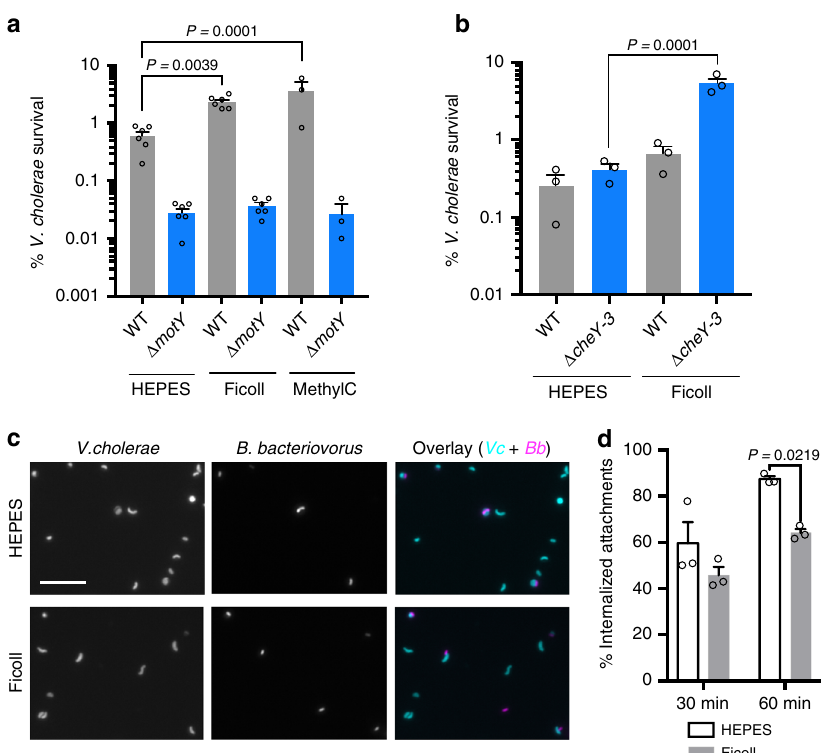
Fig. 4 Increasing viscosity reduces killing and invasion of motile V. cholerae . a , b The survival percentage of motile and non-motile V. cholerae strains in HEPES medium alone or supplemented with fi coll or methylcellulose to increase viscosity. Infections were carried out for 14 h with an MOI of 0.1. Survival percentage and SEM is shown for three to six biological replicates. c Fluorescence microscopy of B. bacteriovorus (magenta) and V. cholerae (cyan), following 1 h of infection at MOI 0.1 in HEPES or Ficoll-supplemented medium. Scale bar indicates 10 µ m. d Images from c were scored for externally attached or internalized B. bacteriovorus at 30 and 60 min. The percentage of internalized attachments and SEM is shown for three biological replicates. Error bars represent standard error of the mean. Statistics were analyzed by ANOVA with Dunnett ’ s multiple comparisons